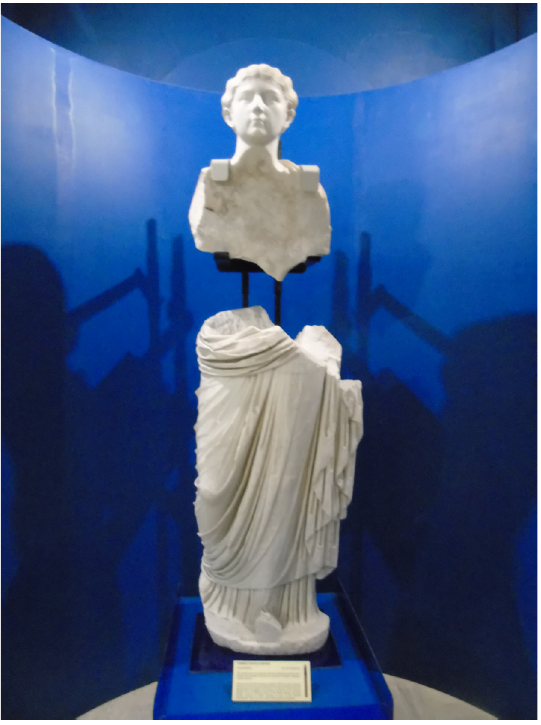
Figure 6: Statue of Claudia Antonia from the Domus Romana (Photo: author, courtesy of Heritage